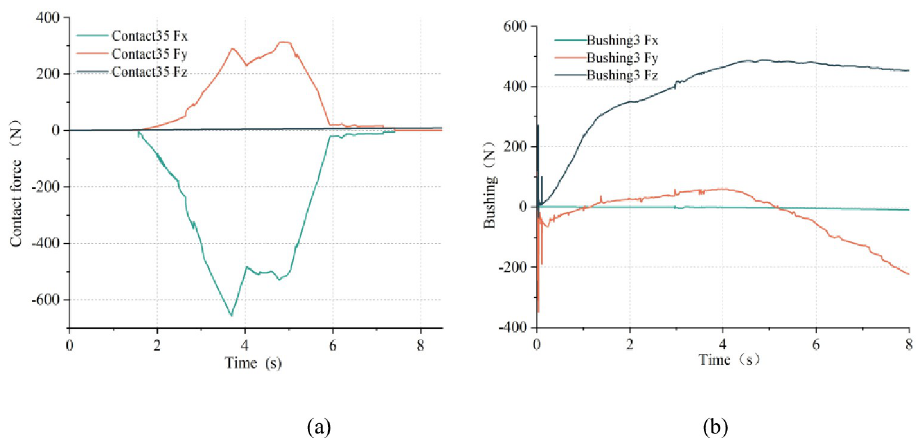
Fig 17. Curves of contact force and bushing: (a) contact force 35; (b) bushing 3.